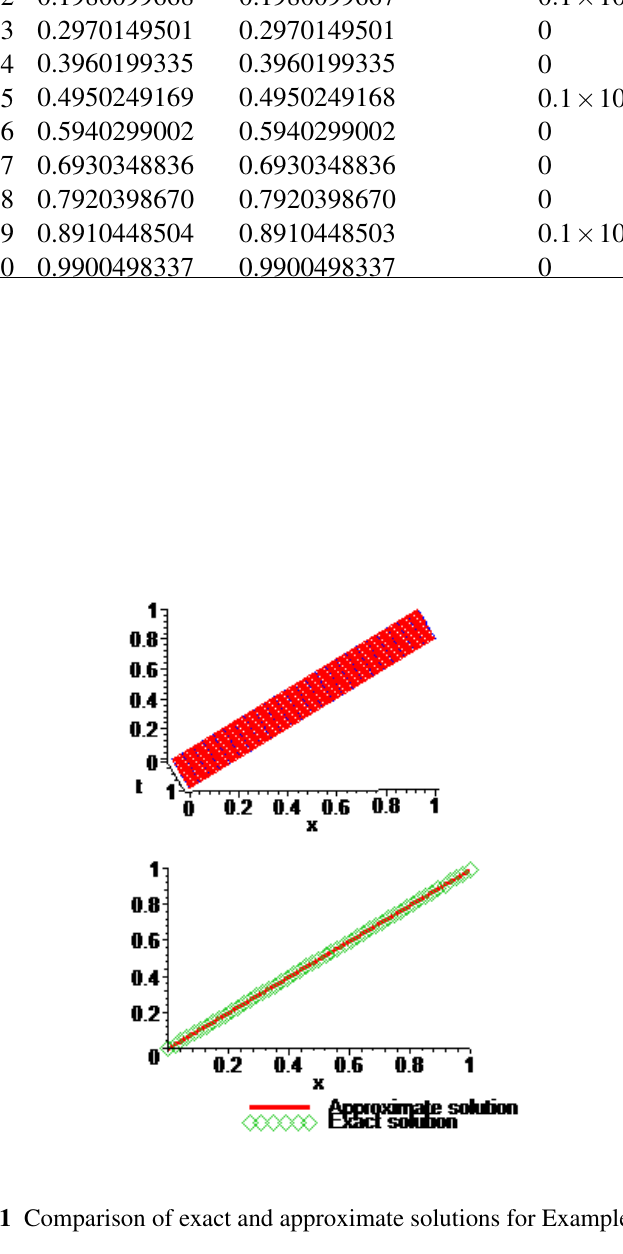
Fig. 1 Comparison of exact and approximate solutions for Example